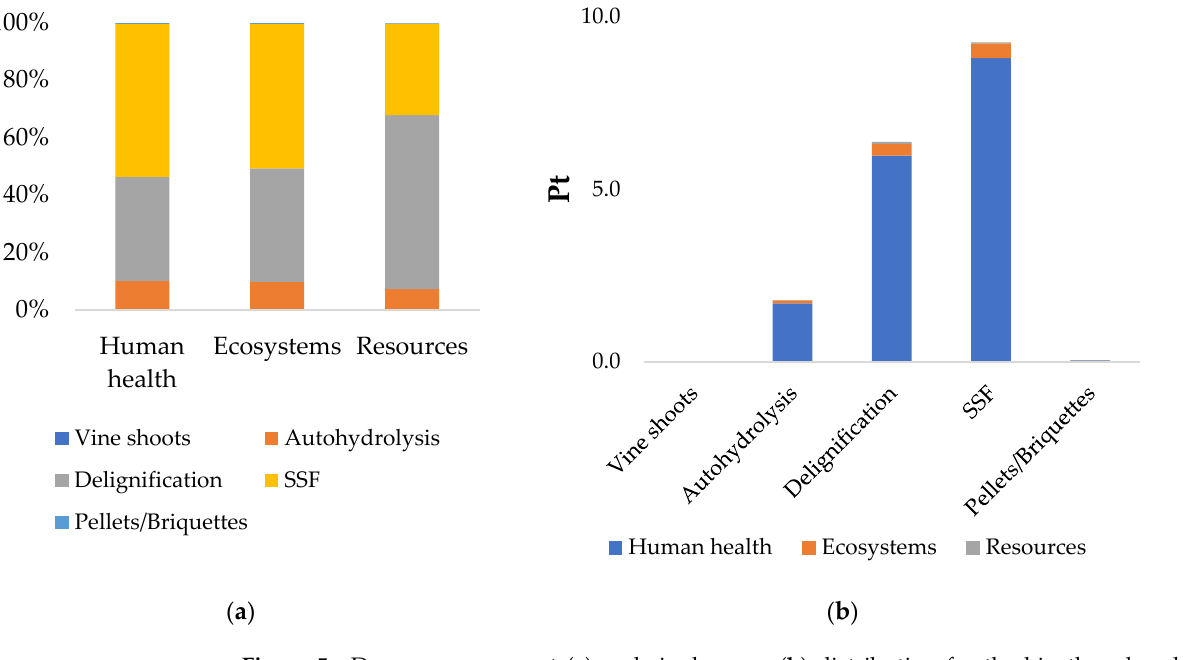
Figure 5. Damage assessment ( a ) and single score ( b ) distribution for the bioethanol and pellets/briquettes production.